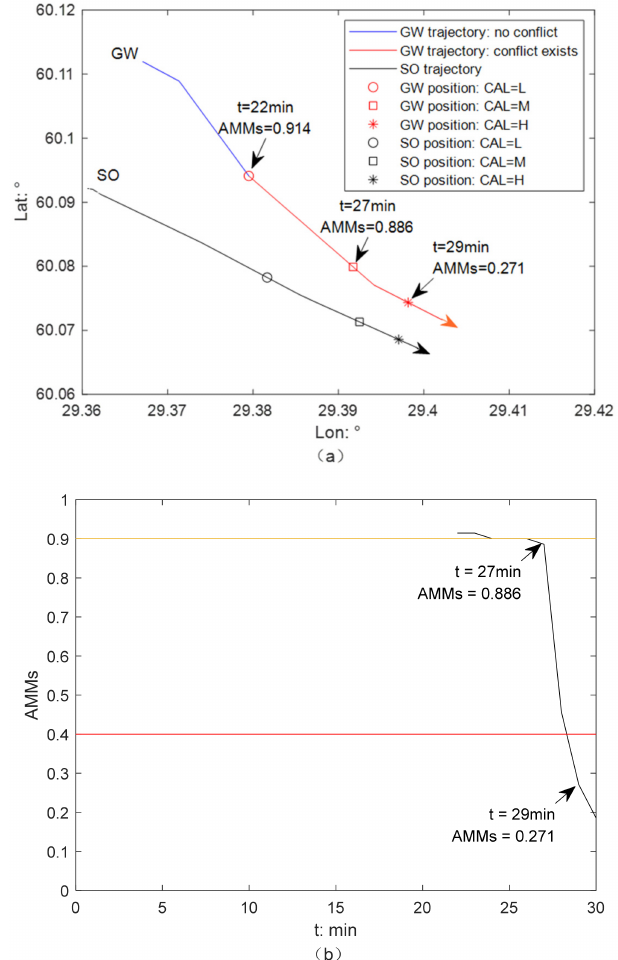
Figure 5. Illustration of the activation of AMM-based CAS from GW perspective in Scenario 1, with ship stability considered: ( a ) collision alert level determination; ( b ) the change of AMM of a